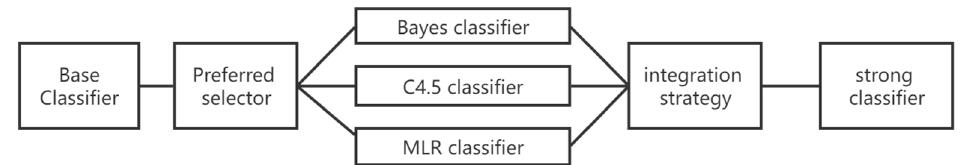
Figure 2. Base Classifier Integration.